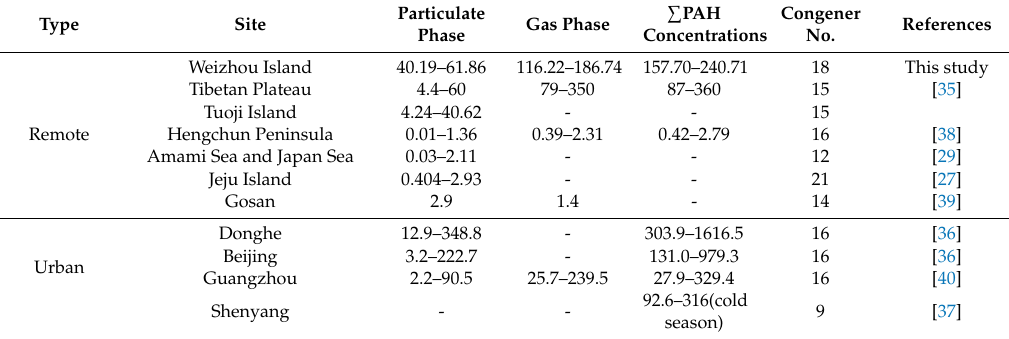
Table 3. Comparison of the total PAHs (ng/m 3 ) at Weizhou Island with some other sites in Asia.